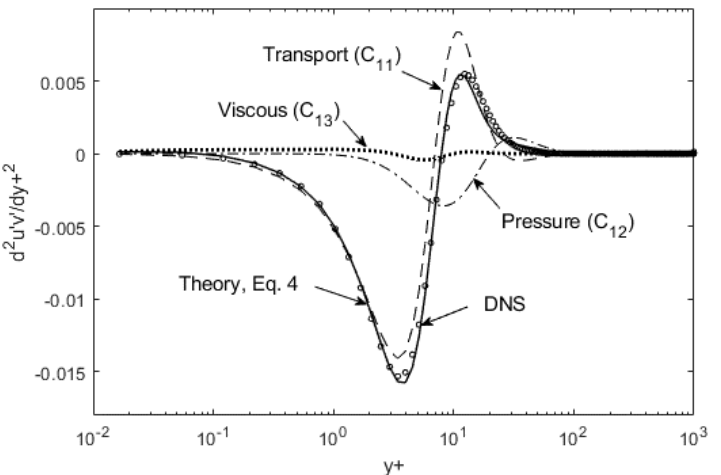
Figure 7. Theoretical prediction of the observed dissipation structure for the Reynolds shear stress, d 2 u’v’/dy+ 2 . DNS data of Graham et al. [12] are used for comparison. Contributions from individual terms in Equation (4) are plotted as different lines (e.g., transport is the C 11 term).